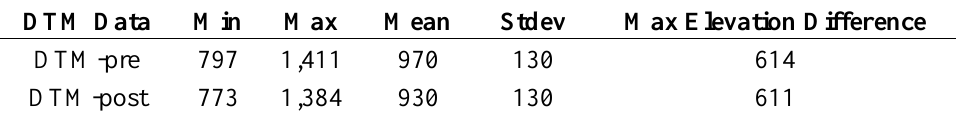
Table 2. Basic statistics for the pre- and post-landslide DTMs (units: